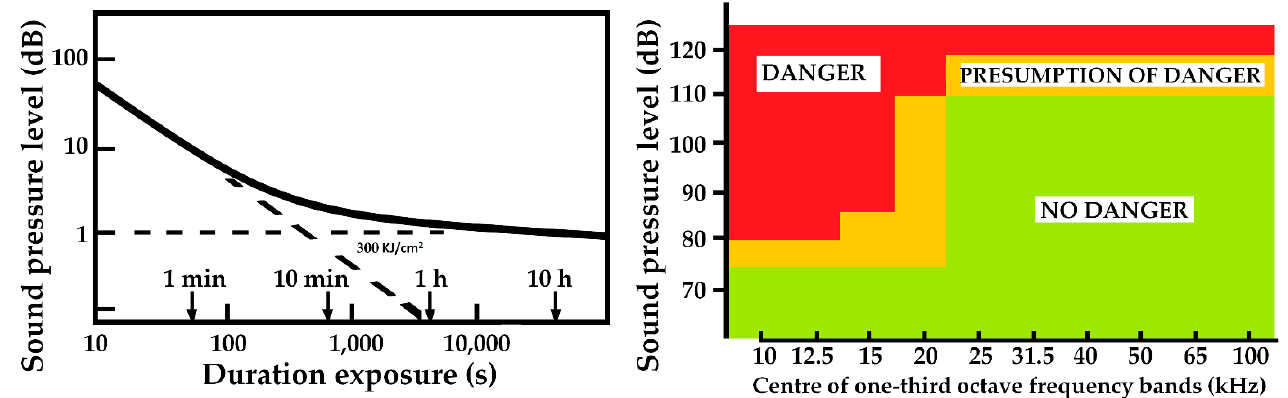
Figure 4. ( Left ) Contact exposure limits proposed by Nyborg in 1978. ( Right ) Recommended maximum limits for exposure to low-frequency airborne ultrasound. Provisional criterion. Status 1985 [2].